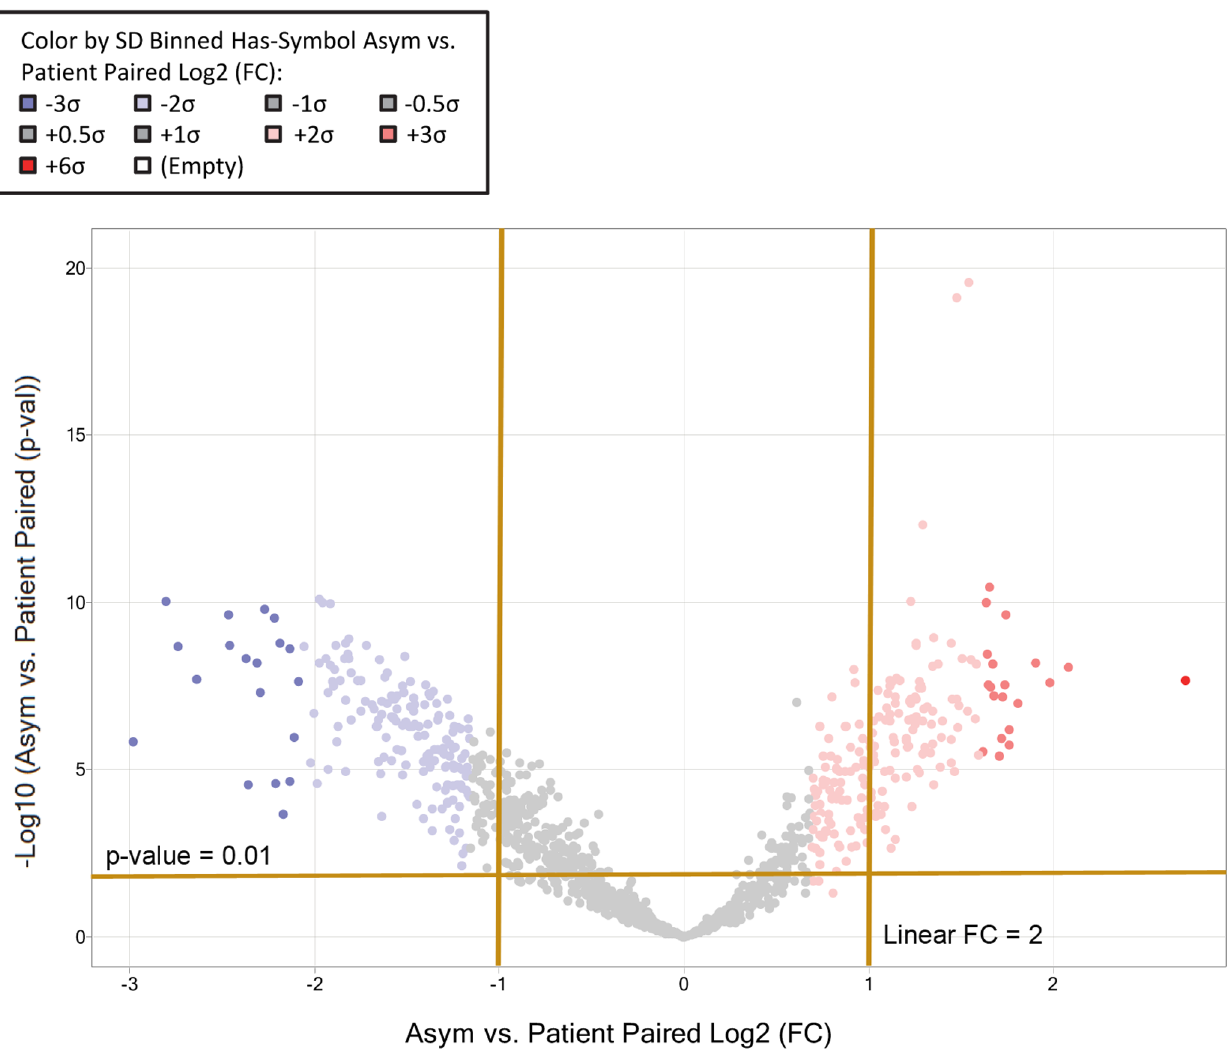
Figure 1. Asymptomatic versus patient paired volcano plot to determine differentially expressed genes. The x -axis shows the paired- sample t-test log 2 fold change of asymptomatic versus symptomatic patients, whereas the y -axis shows the 2 log 10 of the paired t-test p-values of asymptomatic versus symptomatic patients. Each dot represents a gene and the dot color depicts the gene’s expression as shown by the standard deviation (SD) of the paired t-test log 2 fold change, e.g. shades of blue for less than or equal to 2 1 SD, grey for between 2 1 SD and + 1 SD, and red for greater than or equal to + 1 SD. A total of 345 genes were differentially expressed at more than 2 and less than 2 2 linear fold changes (p , 0.01) and were considered statistically significant.